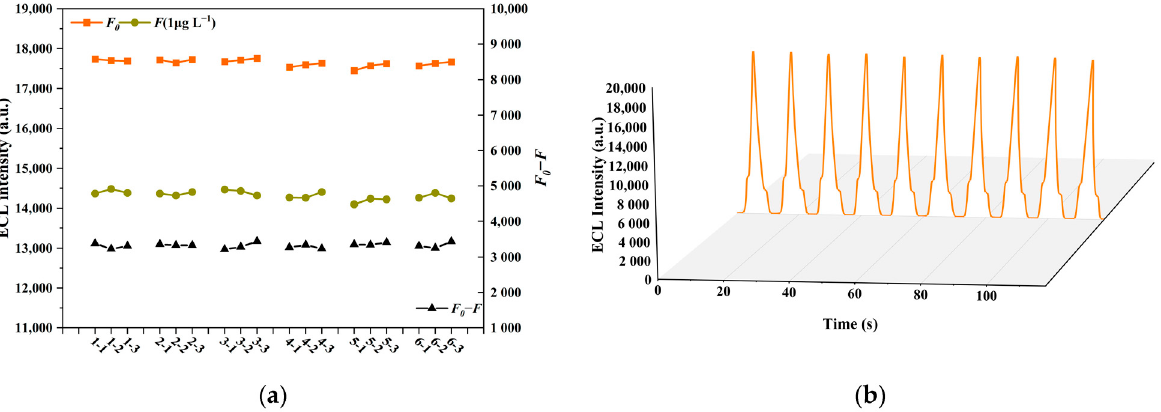
Figure 5. ( a ) The precision of the Eu 3+ -Au@MOF-253 sensor; ( b ) the ECL curve for 10 consecutive detections carried out by Eu 3+ -MOF-253@Au/GCE.